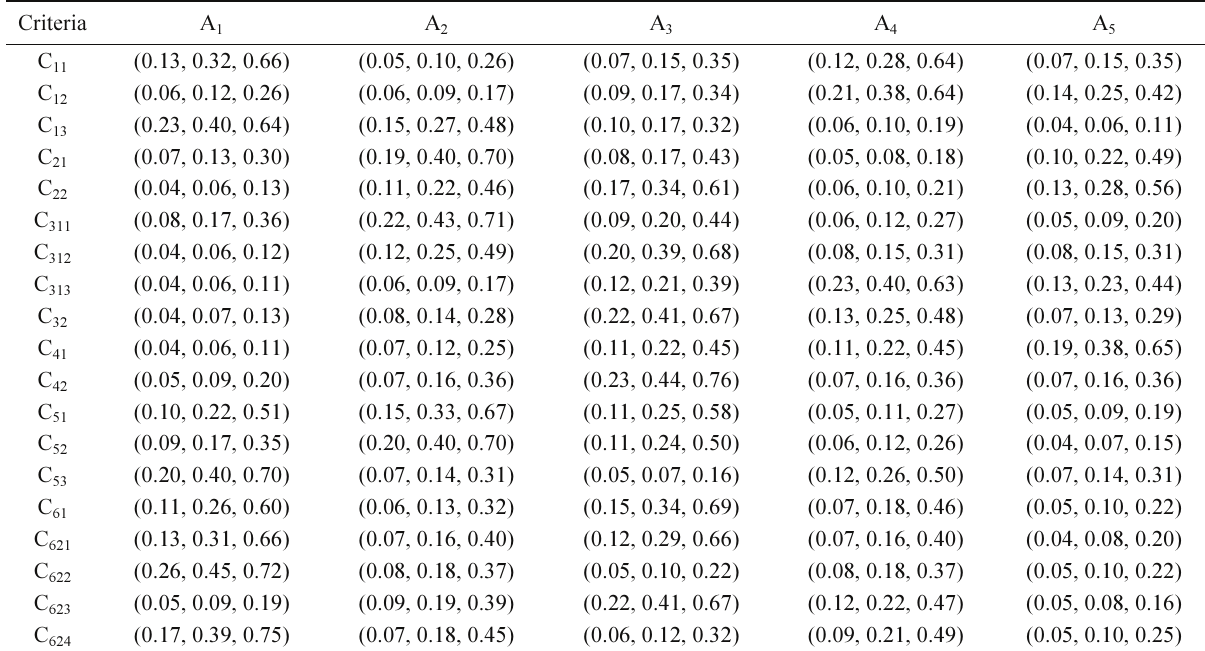
Table 4. Fuzzy weights for each alternative based on each level of